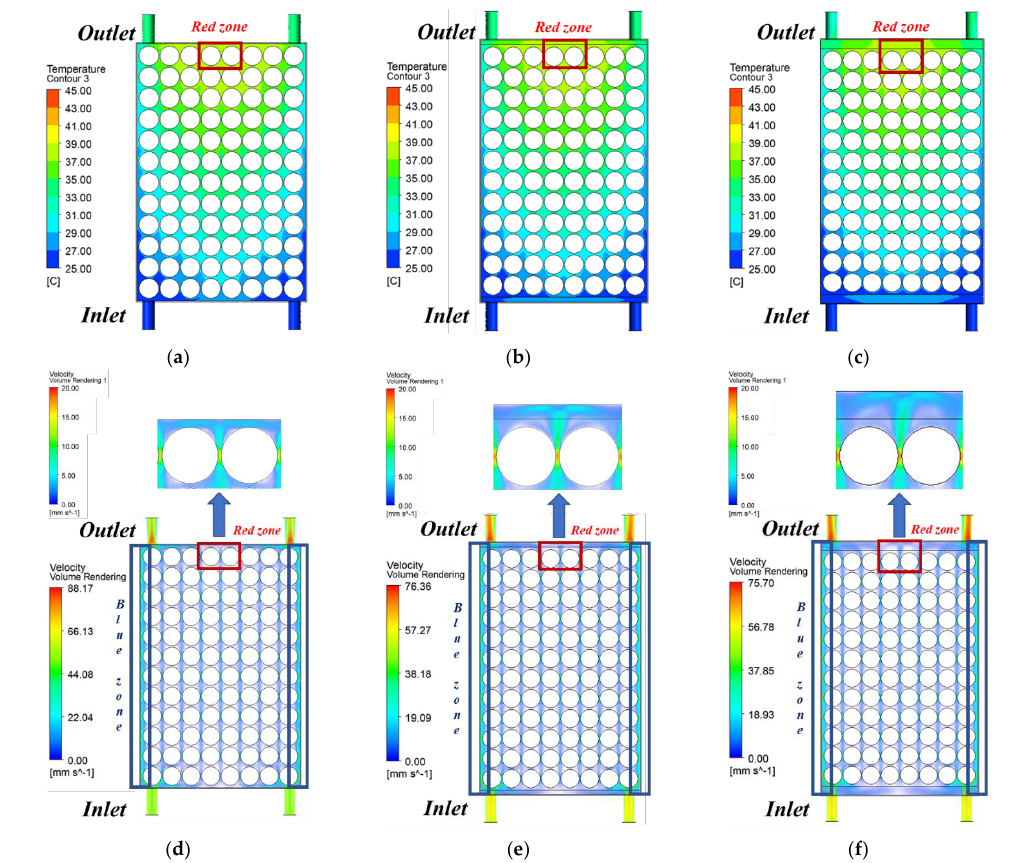
Figure 8. Temperature and velocity distribution according to header width at the battery cooling block with port 2: ( a ) Temperature contour at 0 mm; ( b ) Temperature contour at 5 mm; ( c ) Temperature contour at 10 mm; ( d ) Velocity contour at 0 mm; ( e ) Velocity contour at 5 mm; ( f ) Velocity contour at 10 mm.